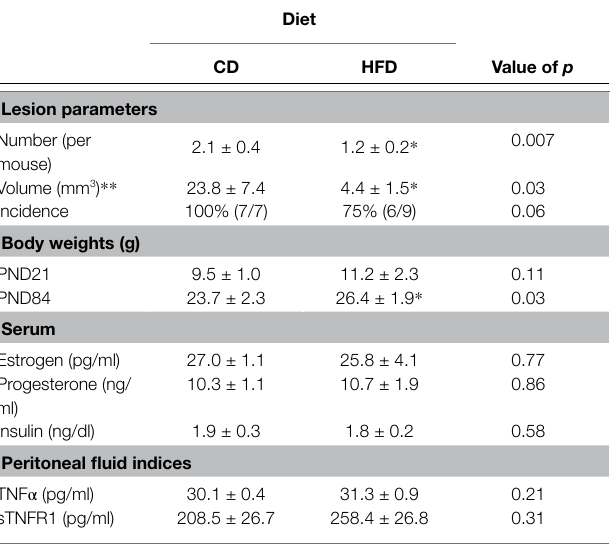
TABLE 1 | Parameters of lesions and recipients exposed to CD or